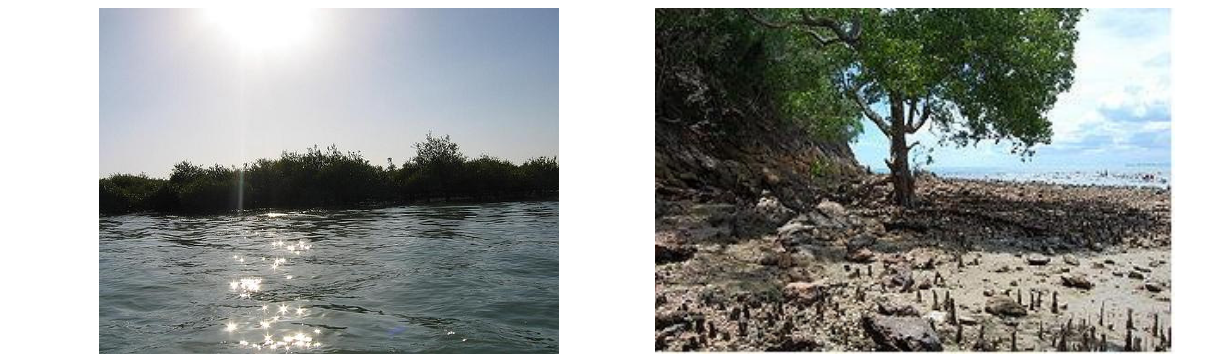
Figure 8: Mangrove tree in coastal area. Figure 9: Mangrove tree in coastal